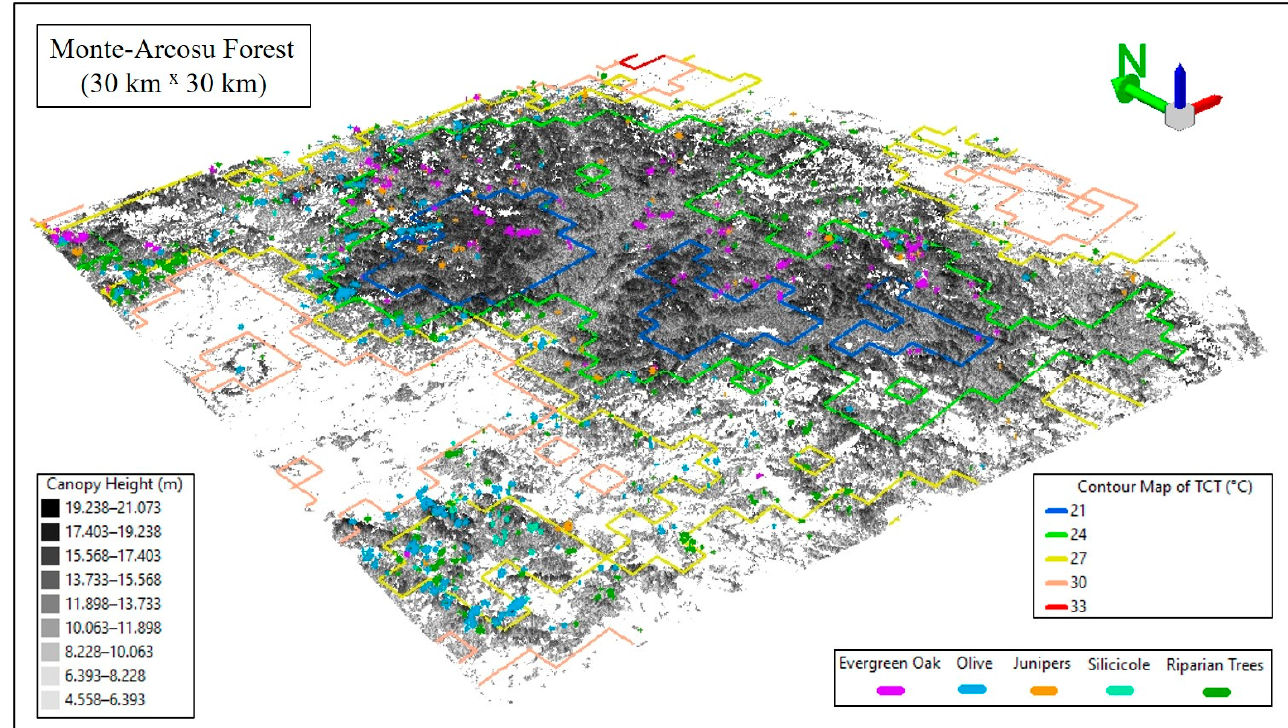
Figure 8. A 3D visualization of canopy heights, vegetation types, and canopy temperatures as contour